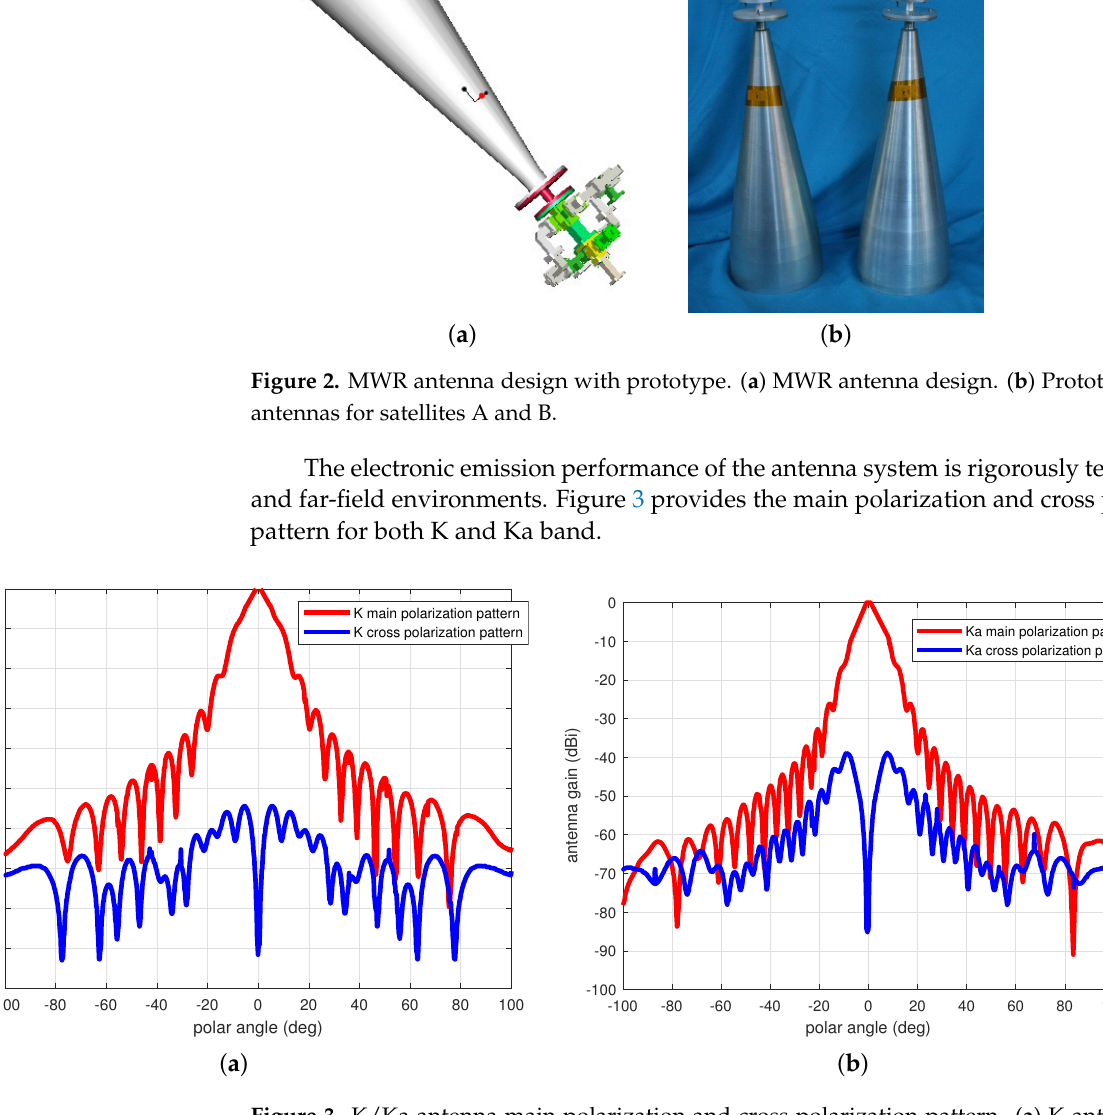
Figure 3. K/Ka antenna main polarization and cross polarization pattern. ( a ) K antenna. ( b ) Ka